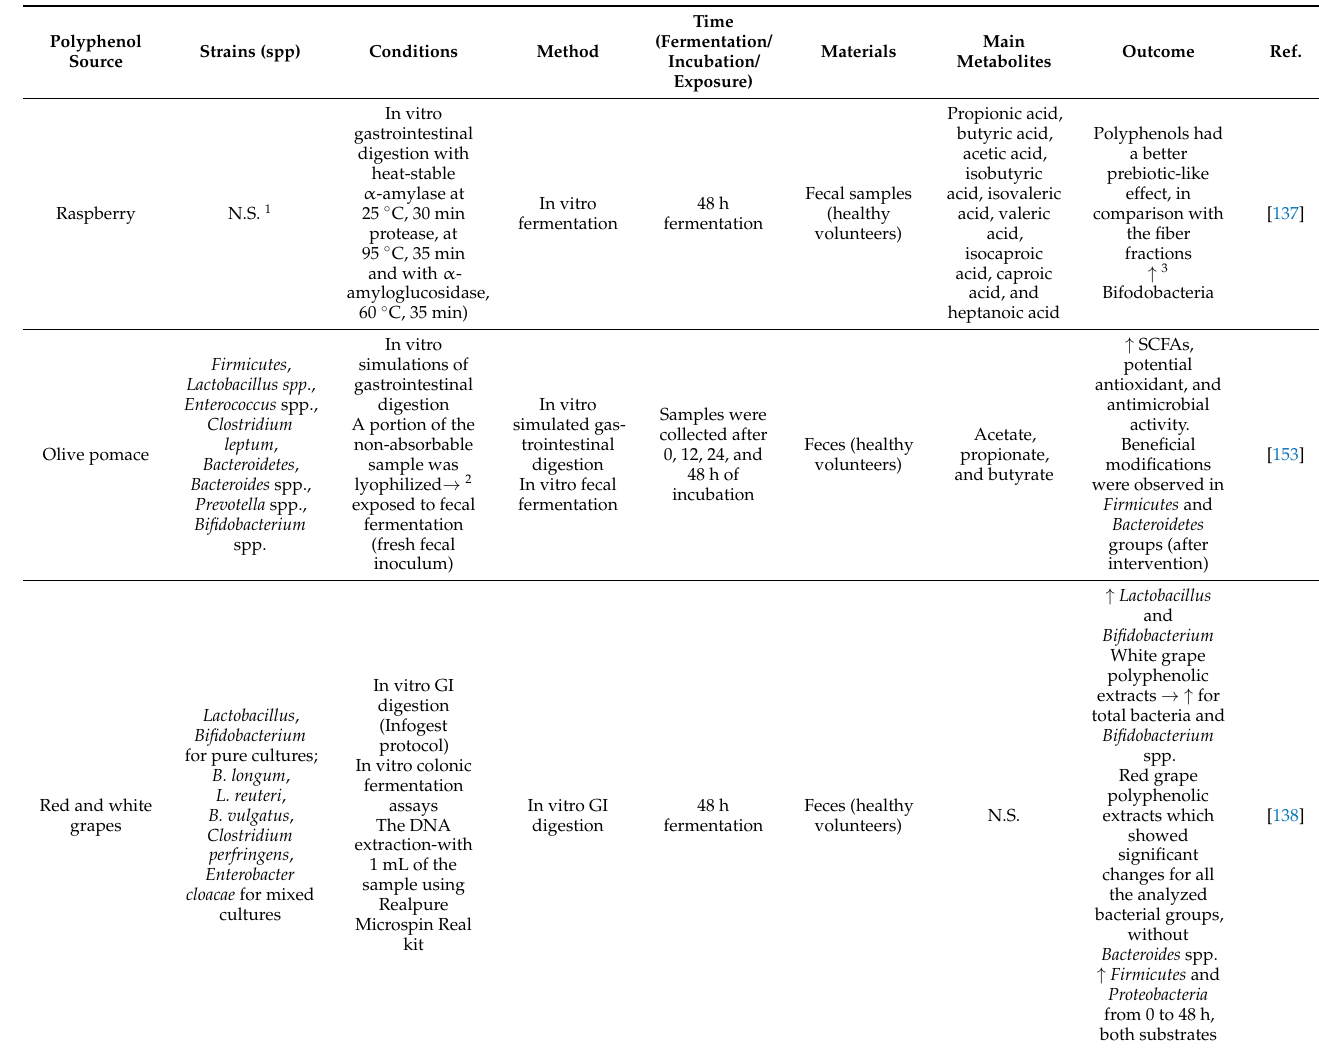
Table 2. In vitro modulation of gut microbiota through polyphenol